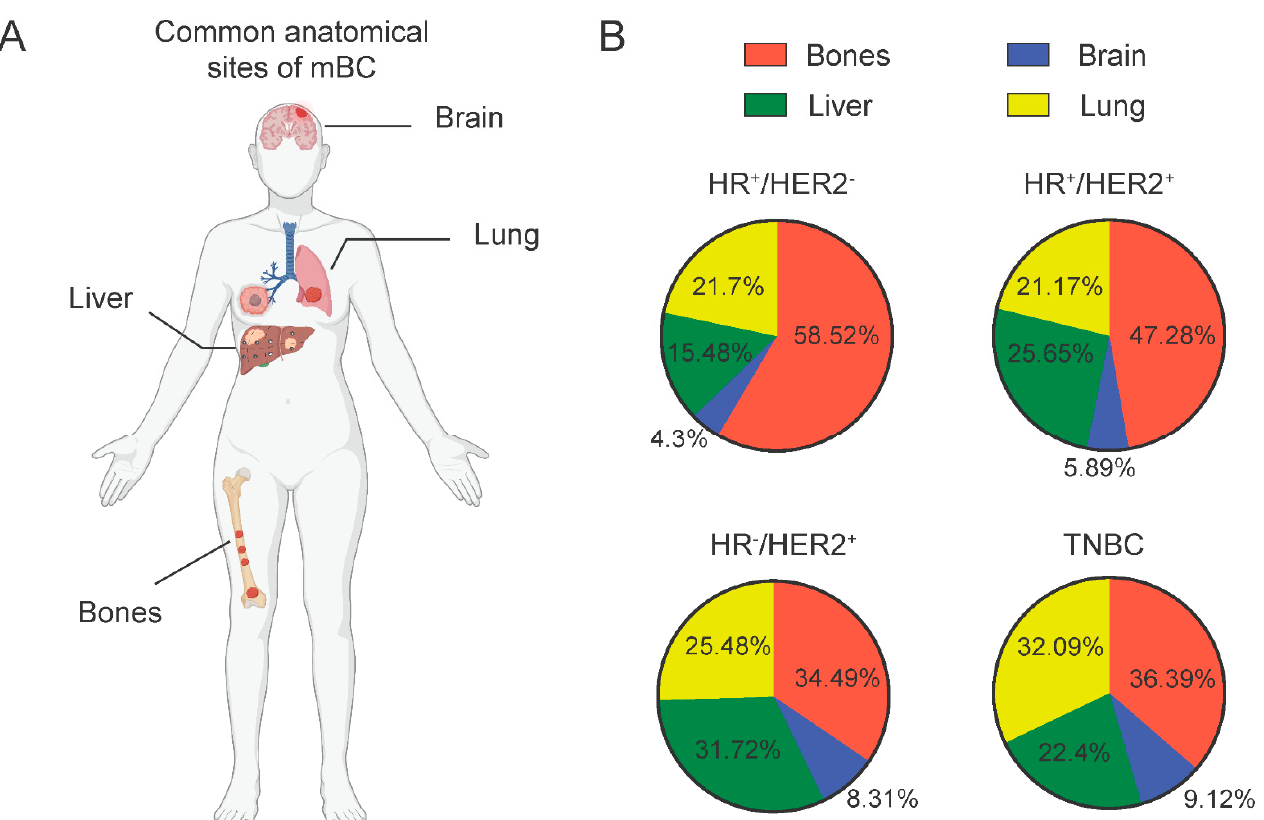
Figure 2. Common metastatic sites of breast cancer subtypes. ( A ) Representation of common metastatic sites in breast cancer patients. ( B ) The frequencies of metastatic sites in breast cancer subtypes, as described previously [22], represented as pie charts.